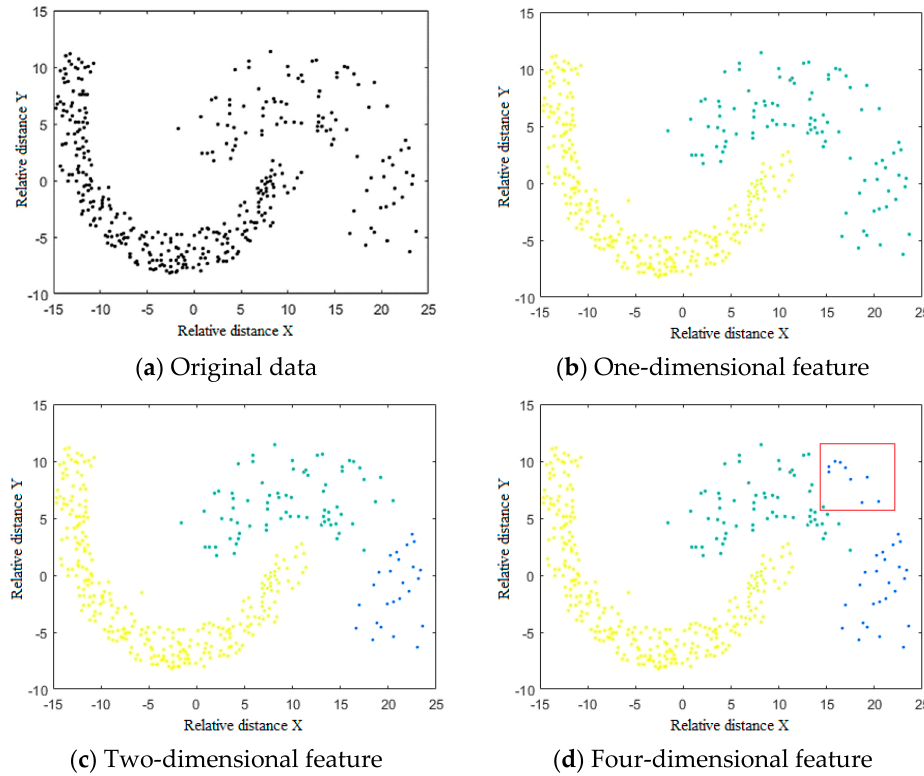
Figure 9. The effects of different topological features on clustering results are presented. Figure 9. The e ff ects of di ff erent topological features on clustering results are presented.